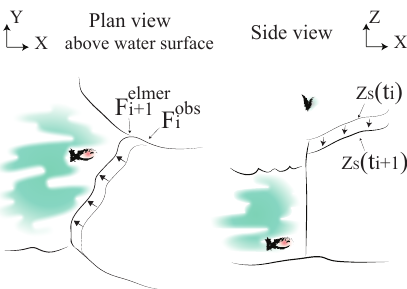
Figure 3. Front position and surface elevation changes with Elmer/Ice during (cid:49)t = t i + 1 − t i